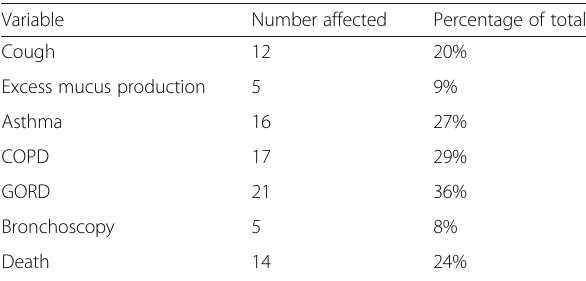
Table 1 Rates of categorical symptoms, comorbidities and healthcare utilisation